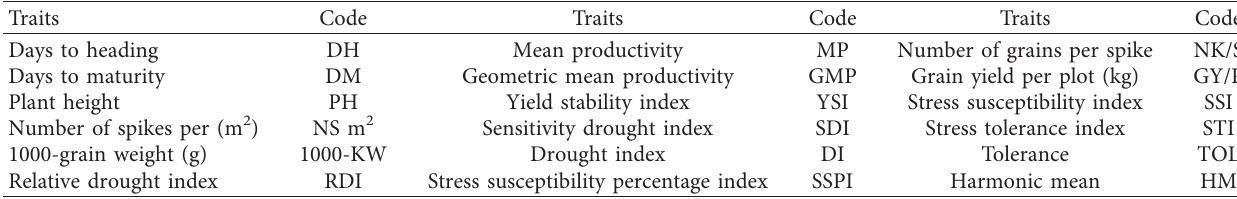
Table 2: The studied traits and their code used in this study.